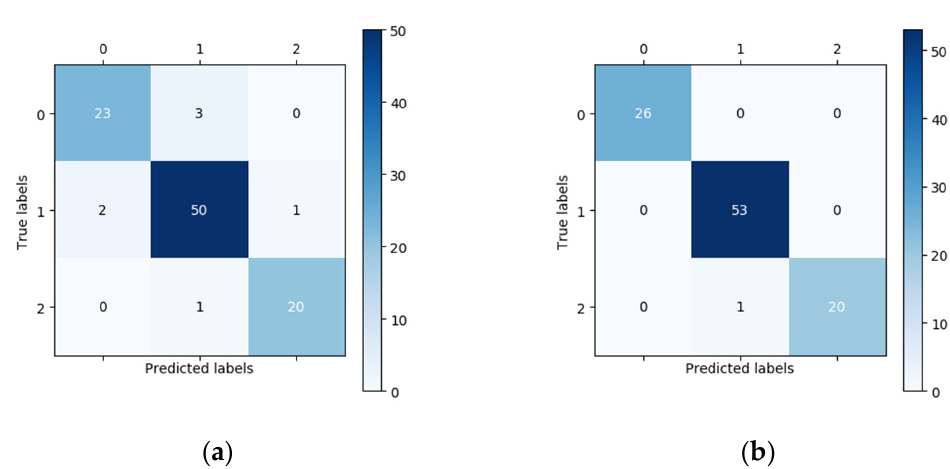
Figure 3. Comparison of the classification performance of the DCNNs and the human expert in the external validation of dataset B. The results are shown as a confusion matrix in which the vertical axis represents the true labels and the horizontal axis represents the predicted labels. ( a ) The confusion matrix of the human expert. ( b ) The confusion matrix of the DCNNs.